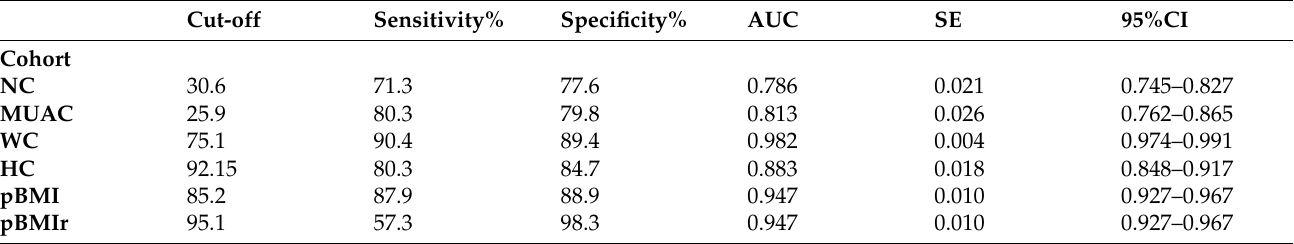
Table 5. Optimal cut-off, sensitivity, specificity, SE and area under the ROC curves for anthropometric indices in predicting obesity in males, females and cohort using